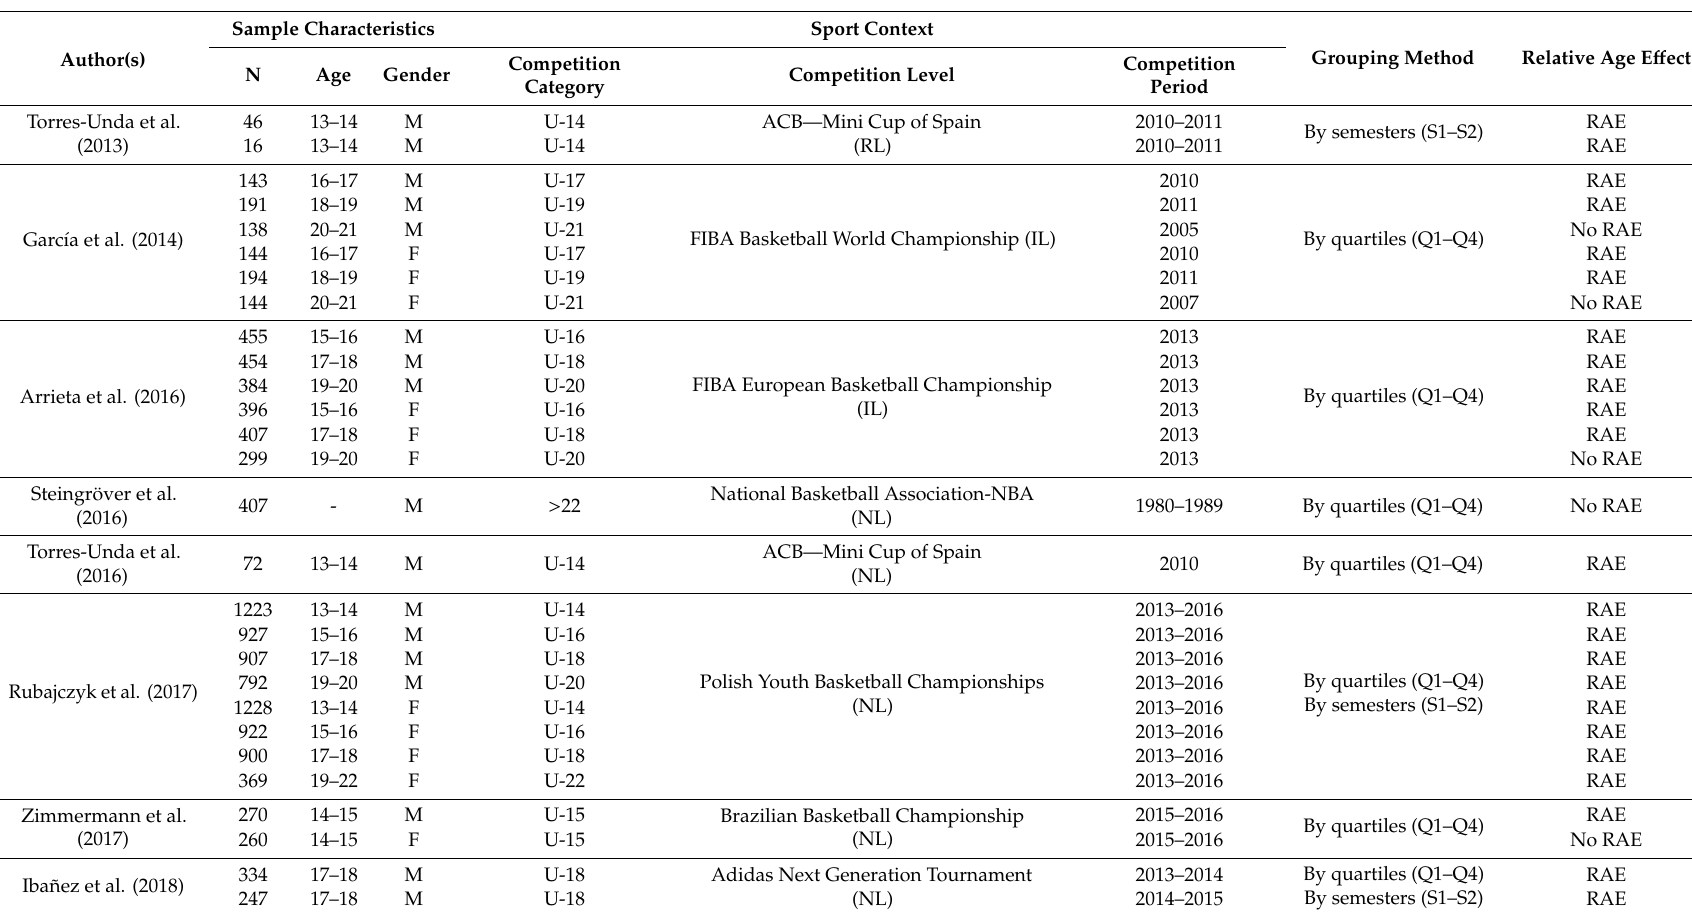
Table 1. Distribution of the sample according to the characteristics of the basketball players (n, age and gender), the sport context (competition category, competition level and competition period), grouping method (quartiles (Q) and / or semesters (S)) and its impact on the set of birthdates (relative age e ff